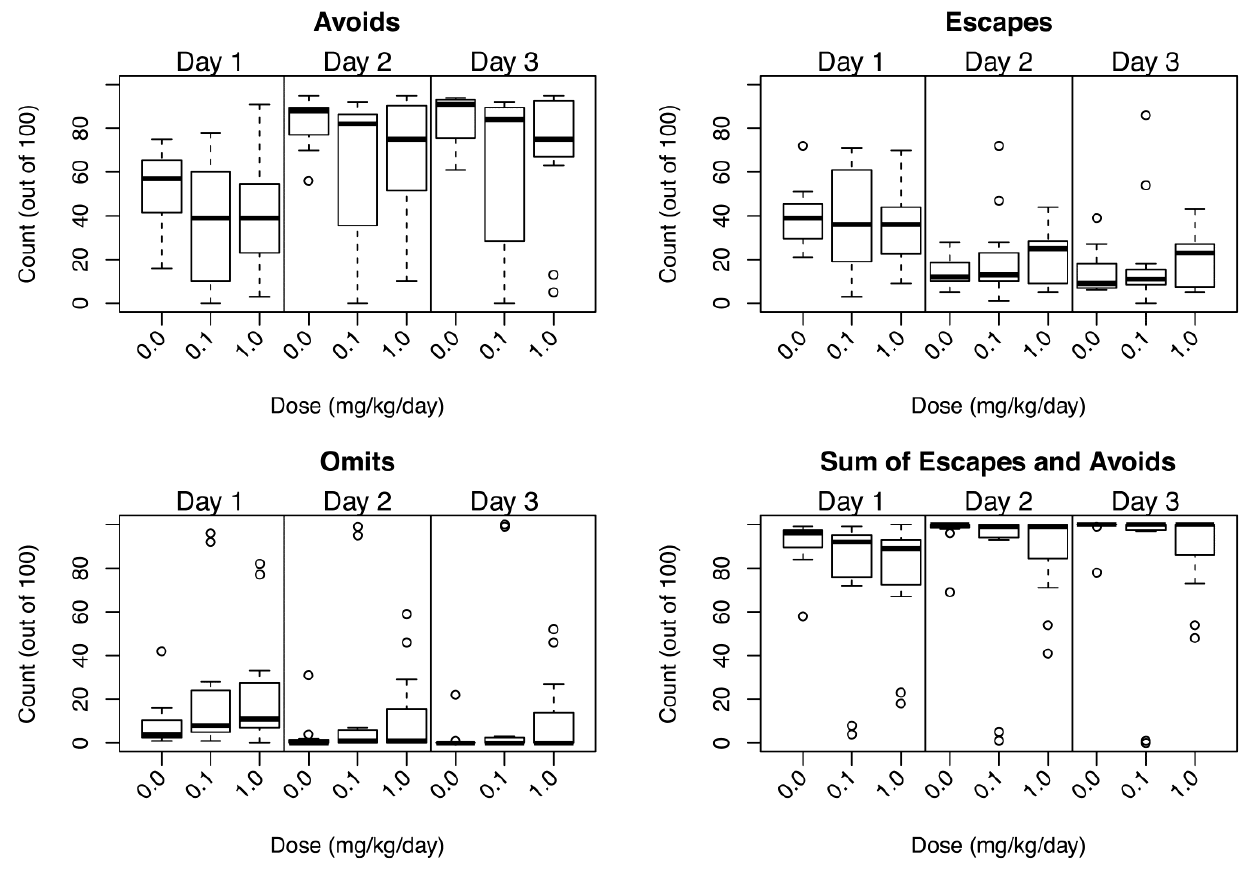
Figure 4. Conditioned Avoidance. Boxplot of Avoids , Escapes , Omits and combined Escape/Omit responses over day 1 of training and days 2 and 3 of retention (median number of responses in 100 trials; the upper and lower quartiles of the response distribution; range of distribution, and extreme observations